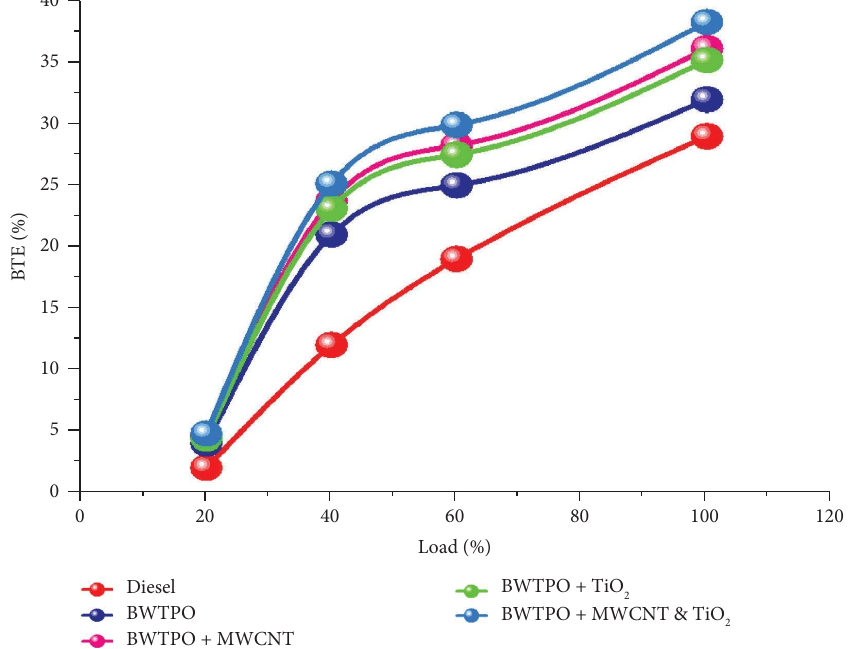
Figure 5: Efciency profle of diesel engines when using diferent fuels at diferent loads.